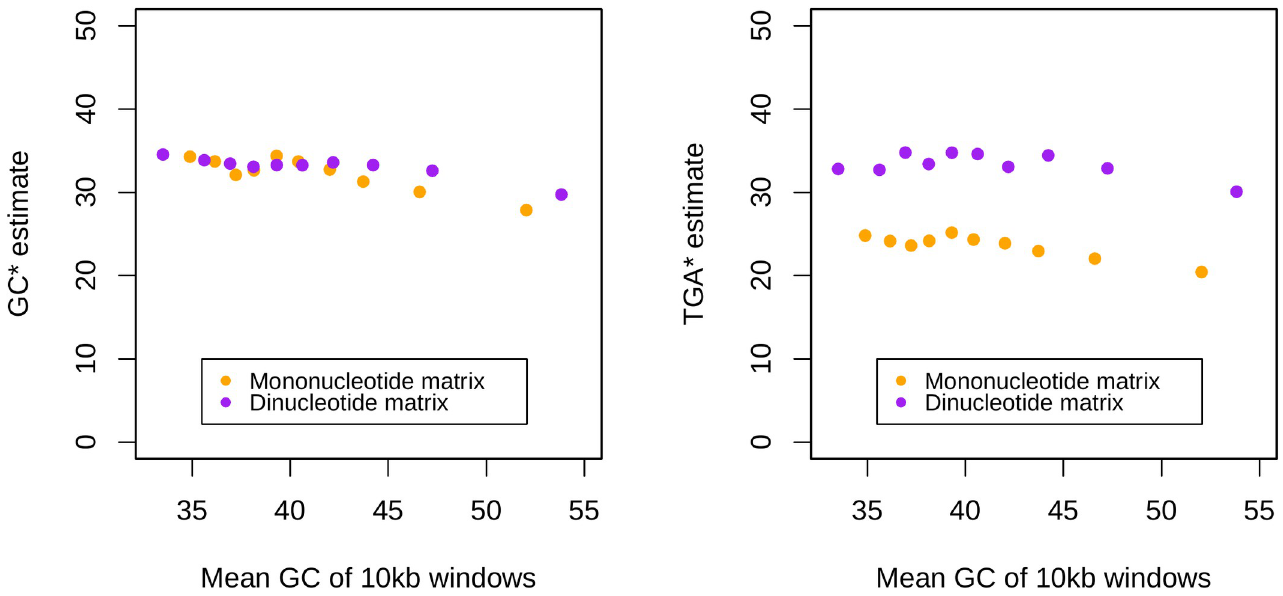
Fig 5. Predicted GC equilibrium (GC � ) and relative TGA equilibrium (TGA � ) frequencies across isochore GC contents derived from mononucleotide (orange) and dinucleotide (purple) mutational matrices. Standard deviations for the datapoints are minuscule and hence error bars are not shown (approximately 0.5% for mononucleotide estimates of TGA � and GC � , approximately 0.5% for dinucleotide estimates of TGA � , and approximately 0.1 for dinucleotide estimates of GC � ). Underlying data can be found in S5 Data.